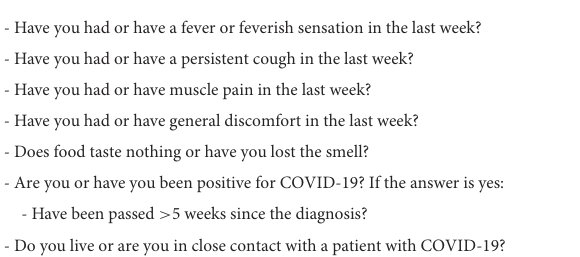
TABLE 2 Rescheduling algorithm for patients screening or testing positive for